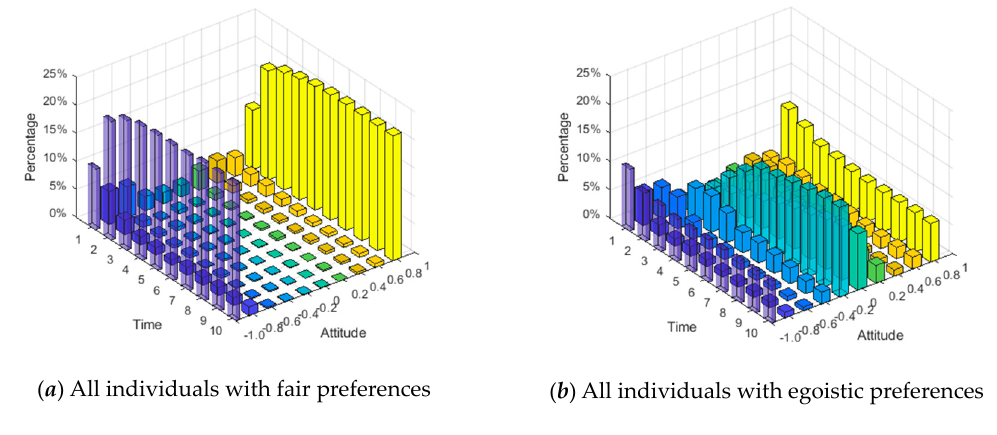
Figure 9. The mottled diagram of the intimacy degree of all nodes.